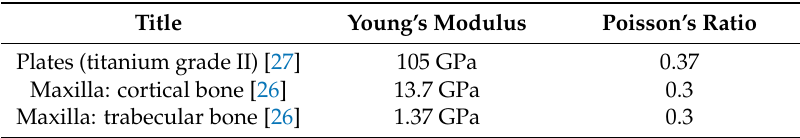
Table 1. Material properties employed in this